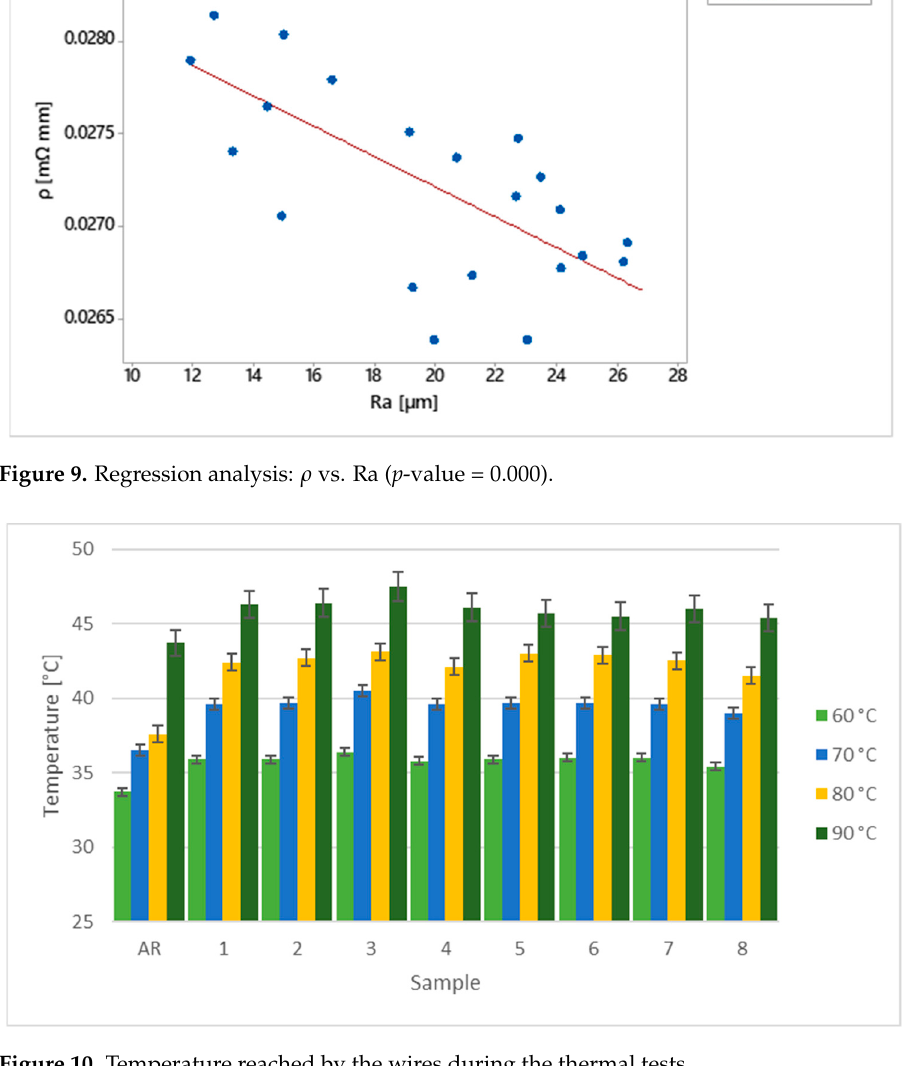
Figure 10. Temperature reached by the wires during the thermal tests.